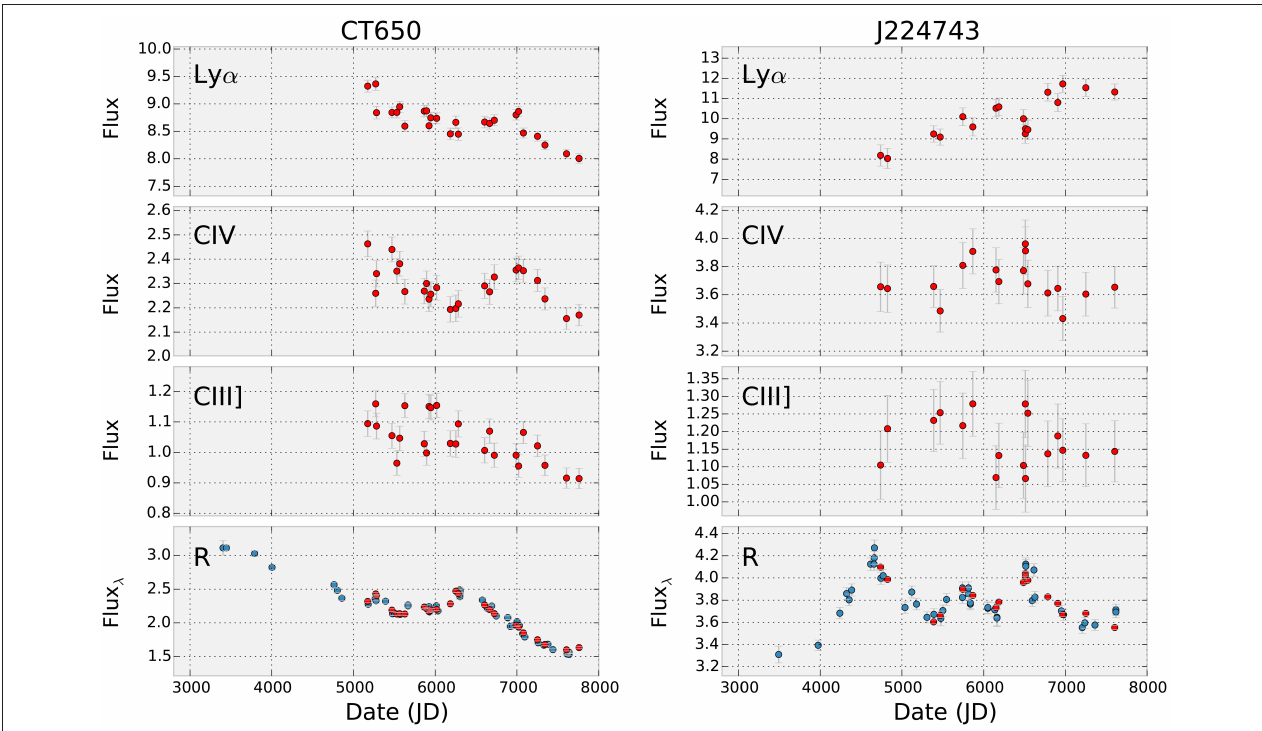
FIGURE 1 | R-band and emission line light curves for a well behaved source, CT650 (Left) , and an anomalous quasar, J224743 (Right) . The time axis is expressed in Julian Dates - 2,450,000 days. Blue points correspond to photometric observations while red points were obtained from the spectroscopic data. The continuum flux measurements shown in the bottom panel, either photometric or spectroscopic, correspond to the observer-frame R-band, and therefore the corresponding rest-frame spectral coverage changes from quasar to quasar. Taken from Lira et al. (submitted), ©